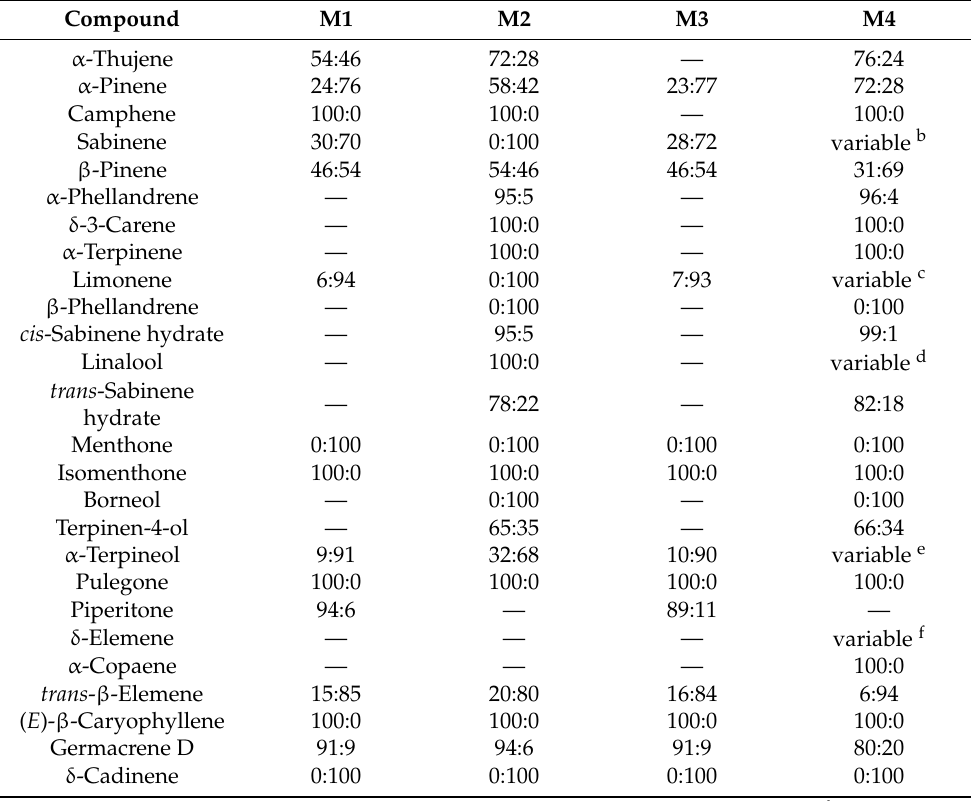
Table 2. Enantiomeric distribution of terpenoid constituents of Pycnanthemum virginianum a .